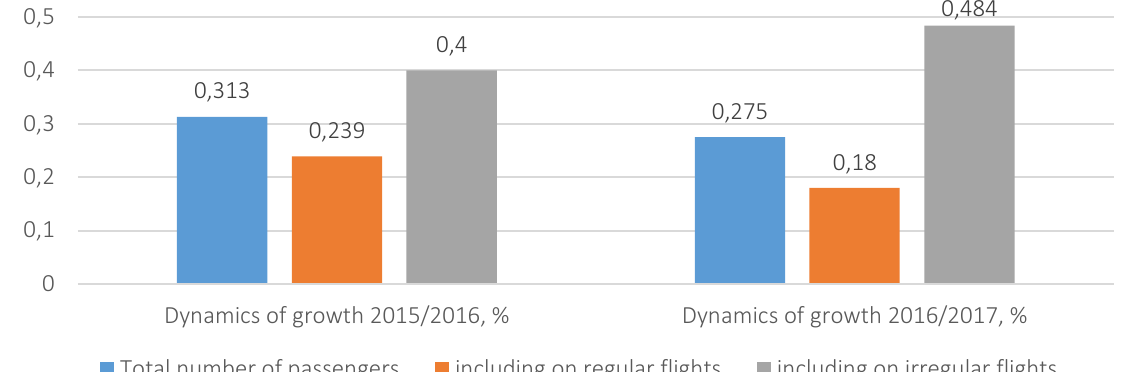
Source: Built based on SAAU